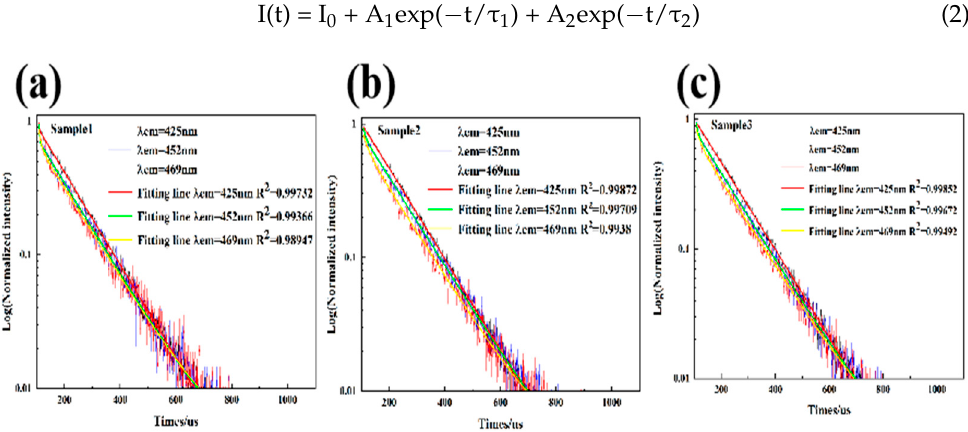
Figure 8. The photoluminescence decay curves of 425 ( a ), 452 ( b ), and 469 nm ( c ) emission peaks of the three samples.